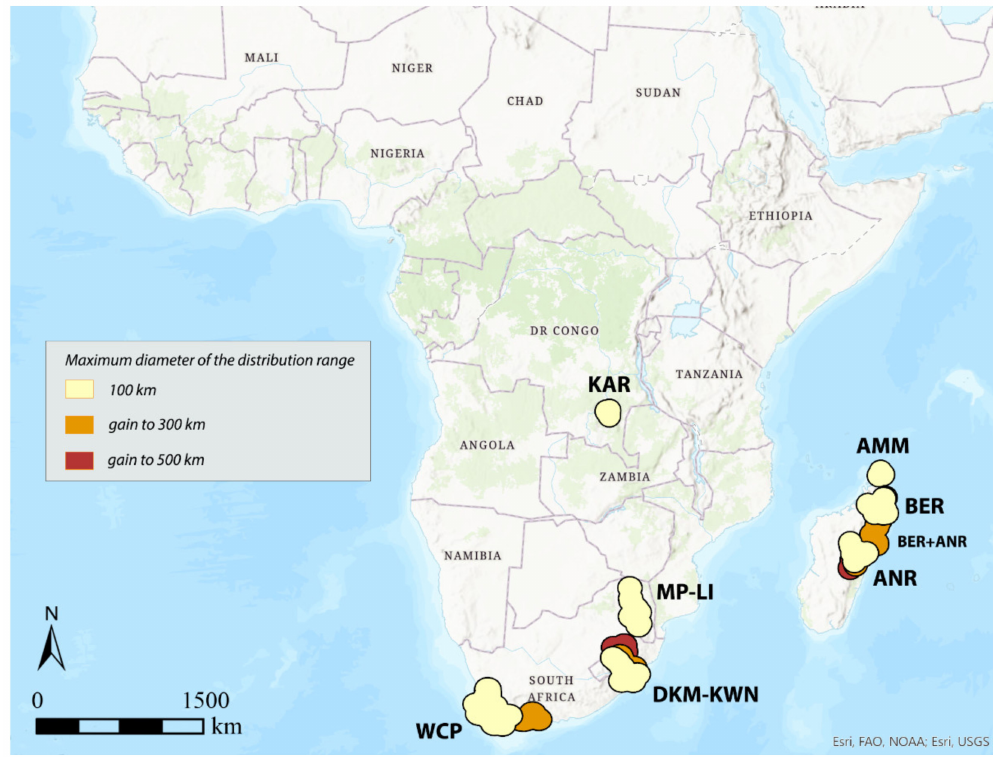
Figure 7. Areas of endemism detected by DBSCAN using the distance between centroids to 100 km and species with distribution range up to 100, 300, and 500 km.